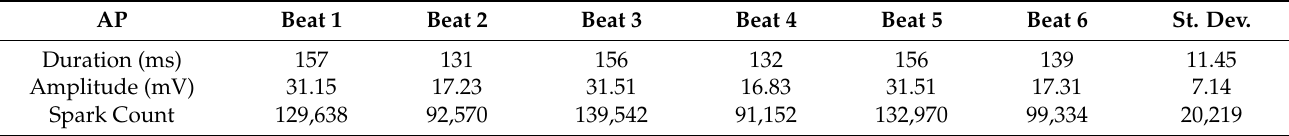
Table 5. Action potential amplitudes, duration, and number of sparks in alternate